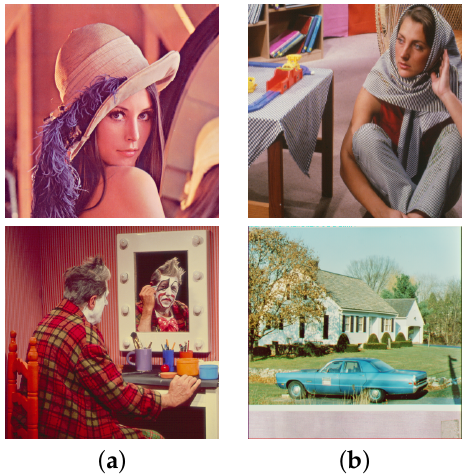
Figure 2. Two pairs of images to be synthesized. ( a ) Two transmission images: ‘Lena’ and ‘Clown’. ( b ) Two reflection images: ‘Barbara’ and ‘House’. The sizes of these four images are all 512 ×